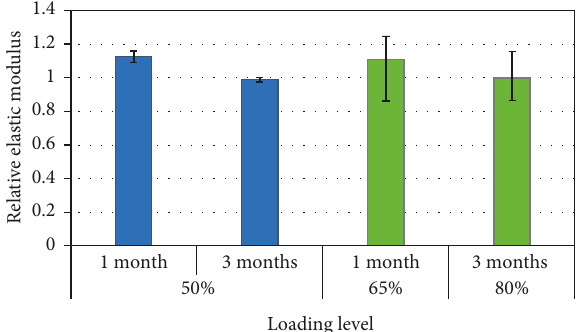
Figure 14: Elastic modulus of creep-loaded specimens (relative to the average unloaded specimens) vs. the creep loading level for two loading ages (1 and 3months). The error bar represents the maximum and minimum relative strength values (for 3 specimens). The variabilities of 3 accompanying control specimens ranged between +0.17 and − 0.1 for a specimen loading level of 65%; +0.16 and − 0.18 for a 50% loading level applied at an age of 1month; and ± 0.03 for 50% and 80% loading levels applied at an age of 3months.